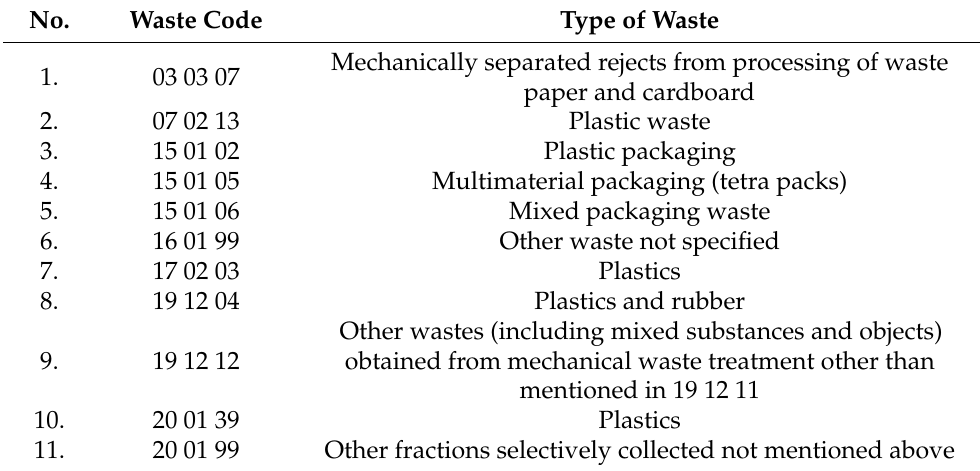
Table 1. Types of wastes processed by the company (the waste code numbers assigned according to Journal of Laws of the Republic of Poland of 2020, item